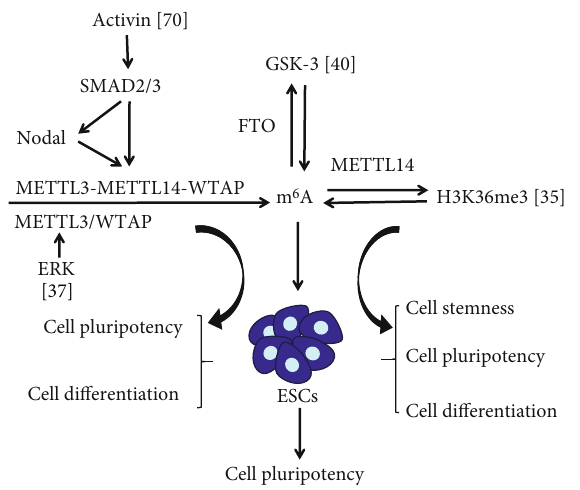
Figure 1: m 6 A RNA methylation interacts with H3K36me3, ERK, GSK-3, and Activin/Nodal signaling pathway to regulate ESC self- renewal, di ff erentiation, cell stemness, and